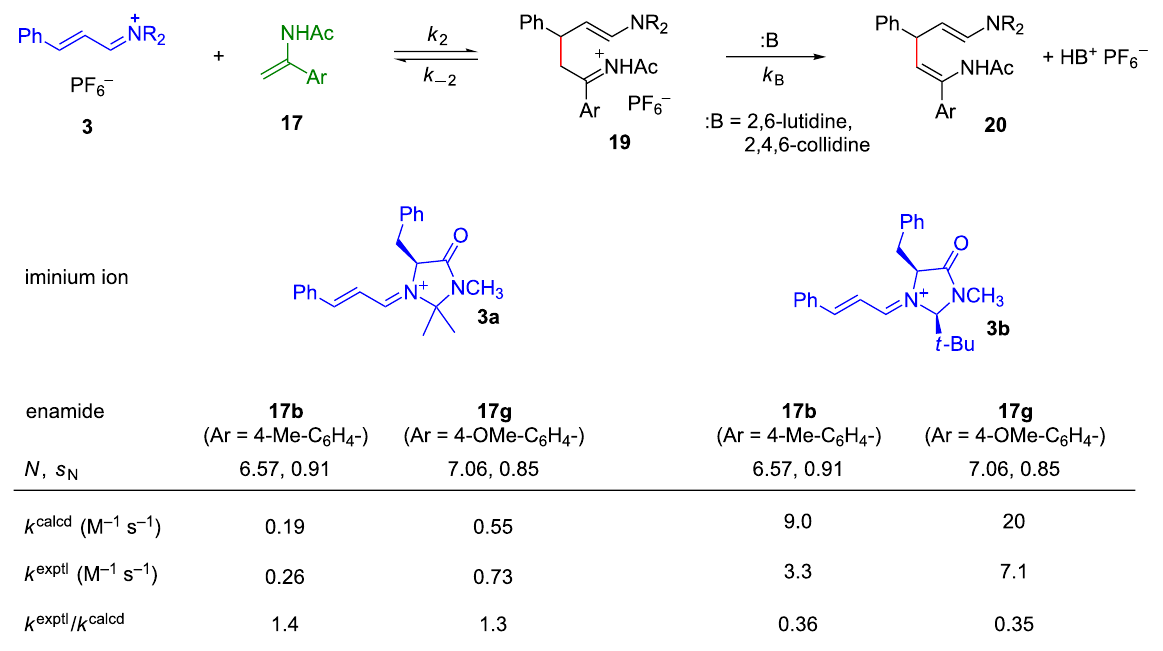
Figure 13: Experimental and calculated rate constants k 2 for the reactions of 17b and 17g with 3a and 3b in the presence of 2,6-lutidine in CH 2 Cl 2 at 20 °C [61].